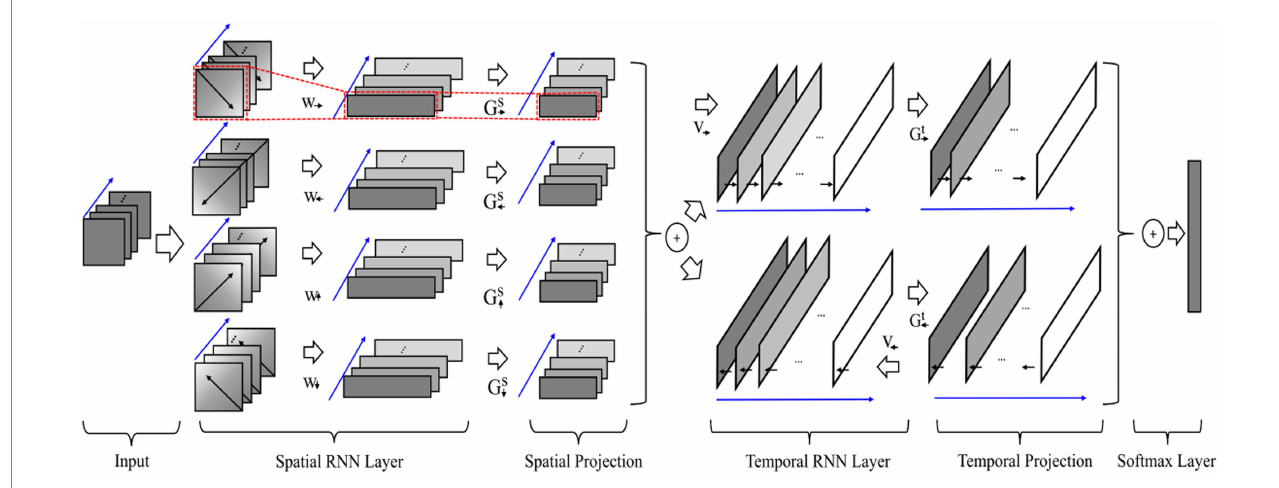
FIGURE 9 The used STRNN framework for EEG emotion recognition (Zhang T. et al., 2018). Reproduced with permission from IEEE. Licence Number: 5493591292973.